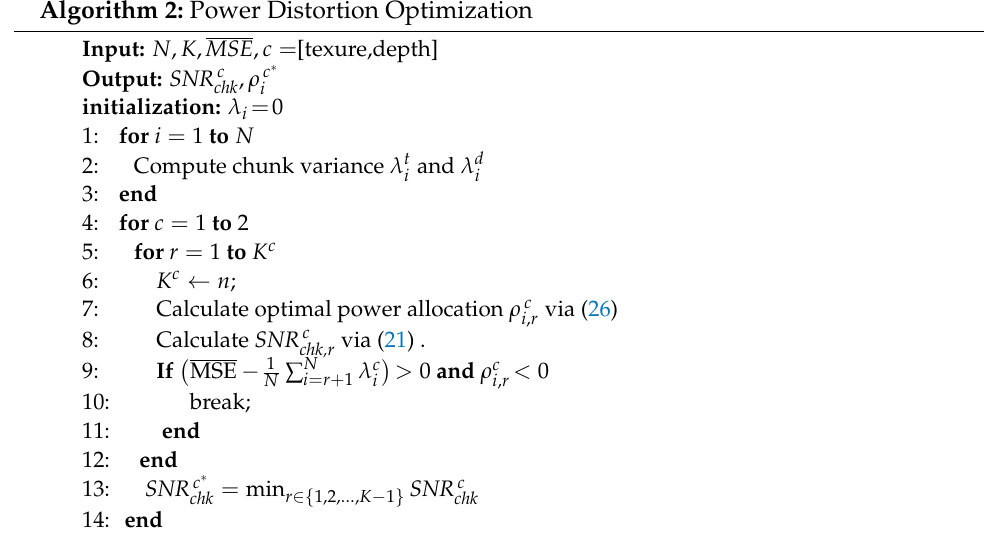
Algorithm 2: Power Distortion